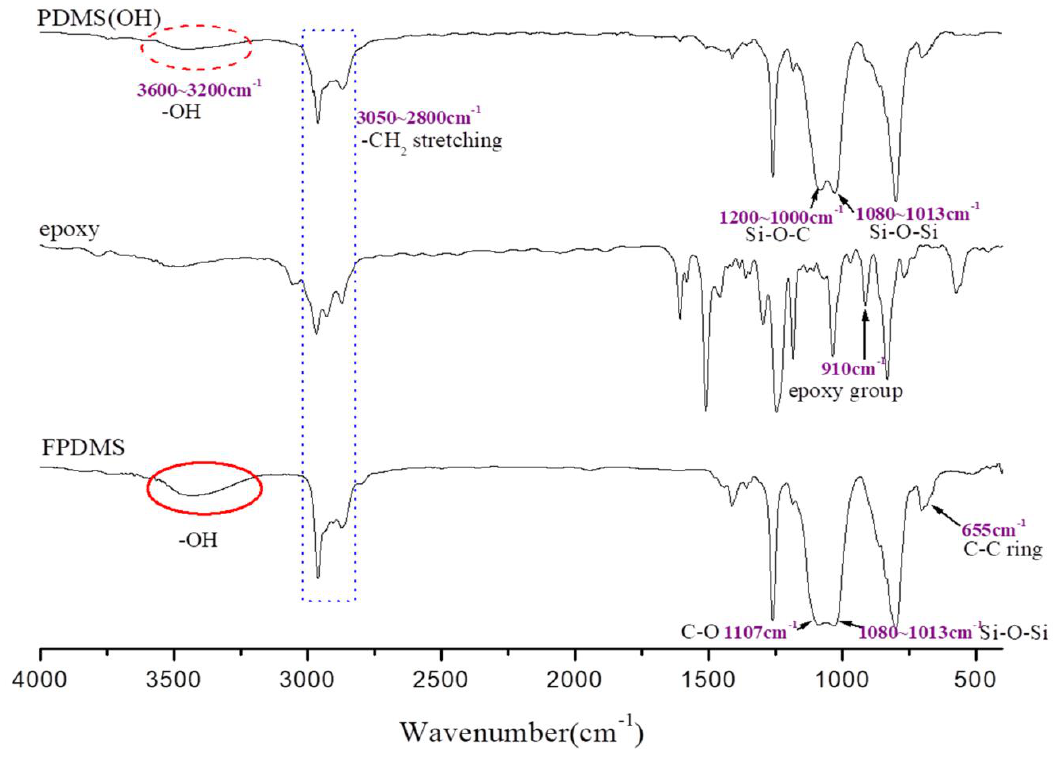
Figure 1. FTIR spectra of PDMS(OH), epoxy and FPDMS.